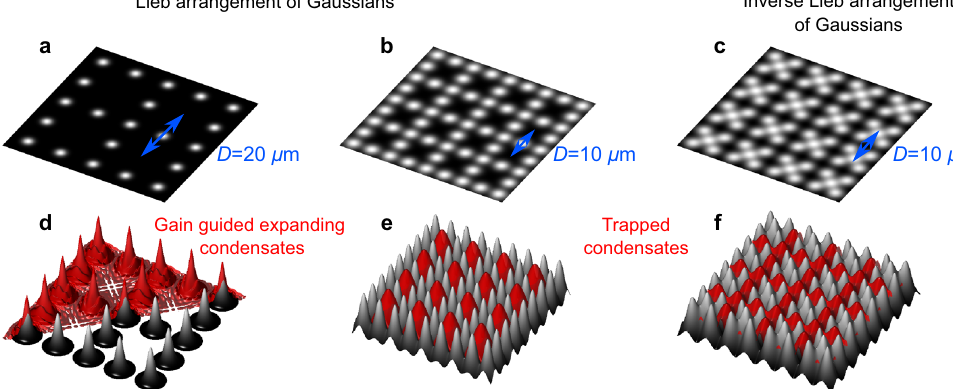
Fig. 1 Schematic of the optical excitation pattern and resulting polariton condensates. a , b Excitation intensity pro fi le composed of Gaussian pump spots arranged in a Lieb pattern for two different lattice constants D and c an inverse Lieb pattern with the potential minima (dark areas) forming a conventional Lieb lattice. d − f Corresponding black-white surface plots of the pump induced potential landscapes with the polariton condensate density overlaid as red envelope. In d polariton condensation occurs on the potential maxima (gain guided condensates) resulting in highly energetic (ballistic) condensate waves whereas in e , f condensation takes place in the potential minima between pump spots.